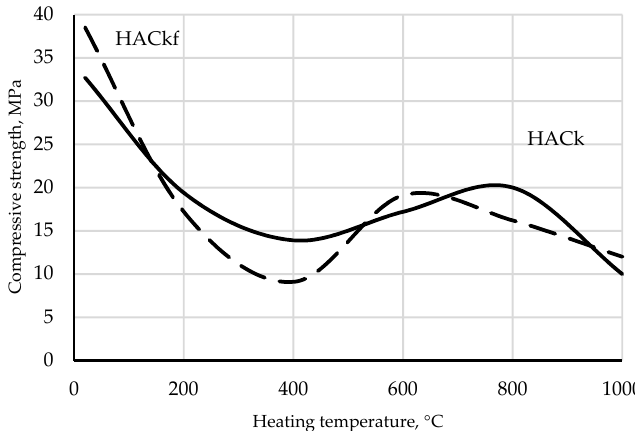
Figure 10. Change in compressive strength of HACk and HACkf concretes.